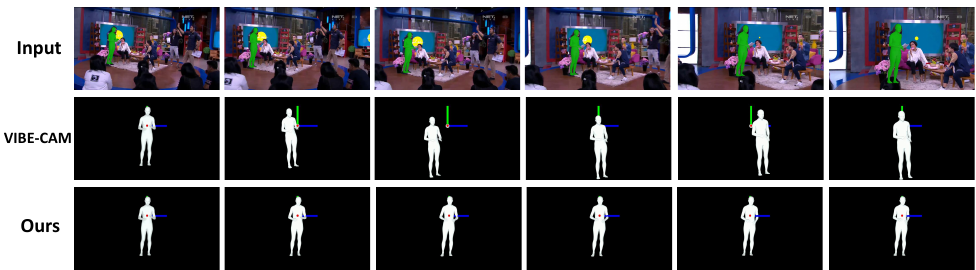
Figure 8. Qualitative comparison on the Mannequin Challenge dataset. The proposed method provides static human poses while VIBE-CAM reconstructs unexpected global human poses with respect to the camera movement in the input video. Note that the reference coordinate systems of VIBE-CAM is aligned with that of the proposed method for easy comparison.